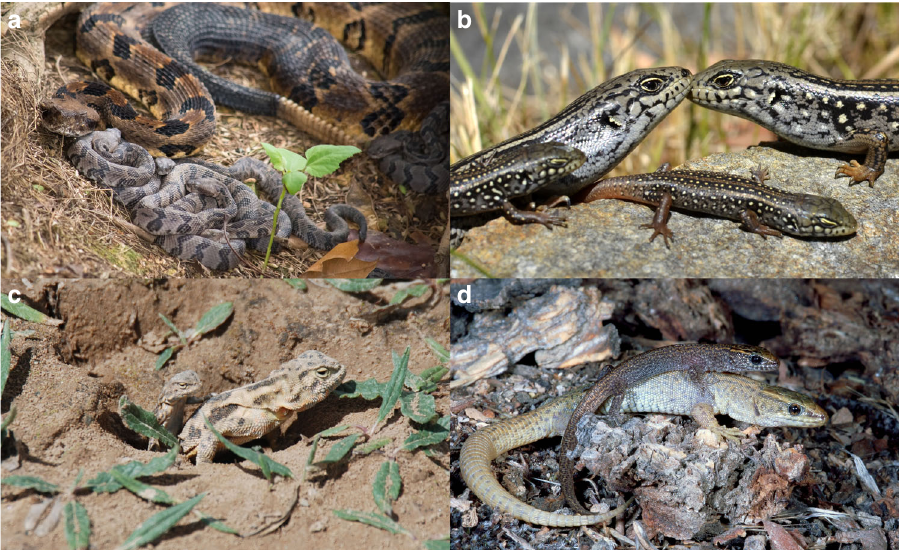
Fig. 1 Inter-generational social grouping occurs in a diverse range of squamate reptiles. For example, social grouping occurs in the viper, Crotalus horridus a , the scincid, Liopholis whitii b , the agamid, Phrynocephalus vlangalii c and the xantusid, Xantusia vigilis d . Photos: J. Williams a , G. While b , Y. Qi c , A. Davis Rabosky